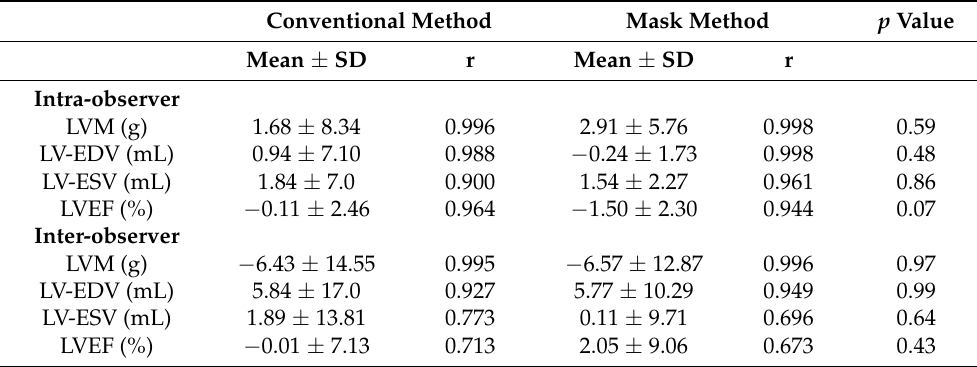
Figure 3. Correlations between mass of papillary and trabecular muscles (MOPTM) index and Ln (NT-proBNP) ( A ), and CK-MB ( B ). Table 4. The intra-observer and inter-observer reproducibility and variability of quantitative analysis with the conventional method and the mask